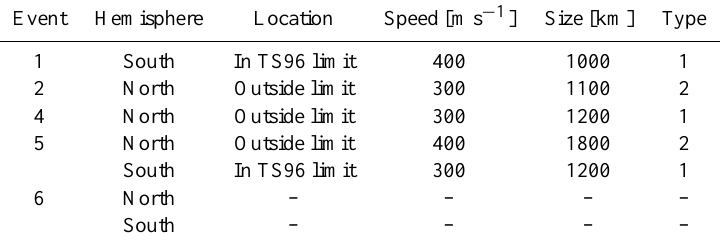
Table 8. Summary of SuperDARN vortices in the Northern and Southern Hemisphere to include footprint location, speed, size, and type. Type 1 refers to a stationary vortex, type 2 refers to a traveling vortex, and type 3 refers to an event having multiple vortices observed at the same time.